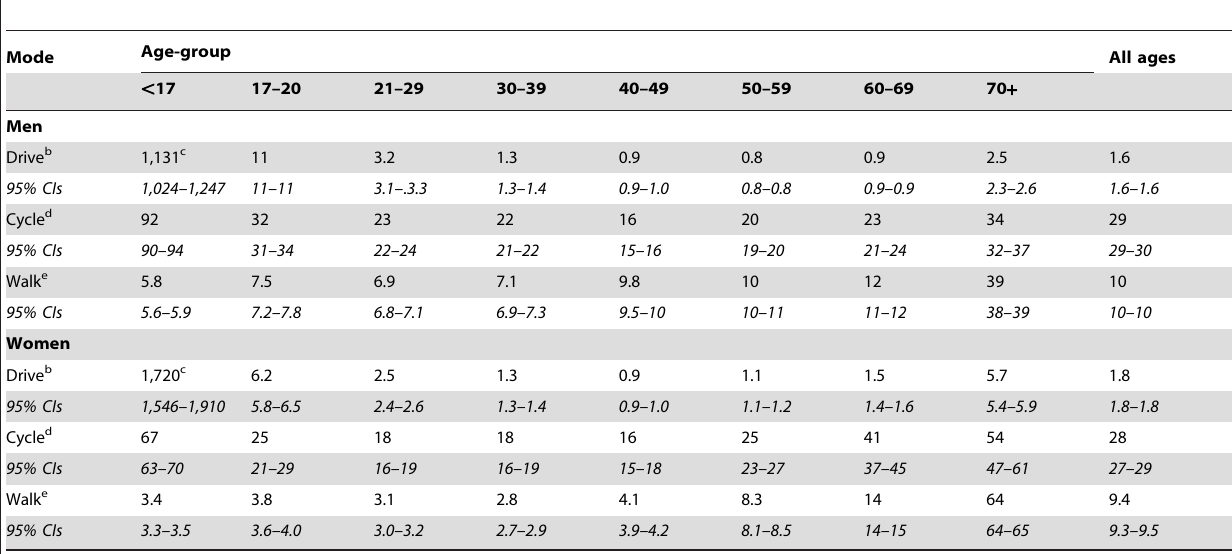
Table 5. Hospital admission rates per million hours travel (mhu a ) by travel mode, age, and sex, England 2007–2009.